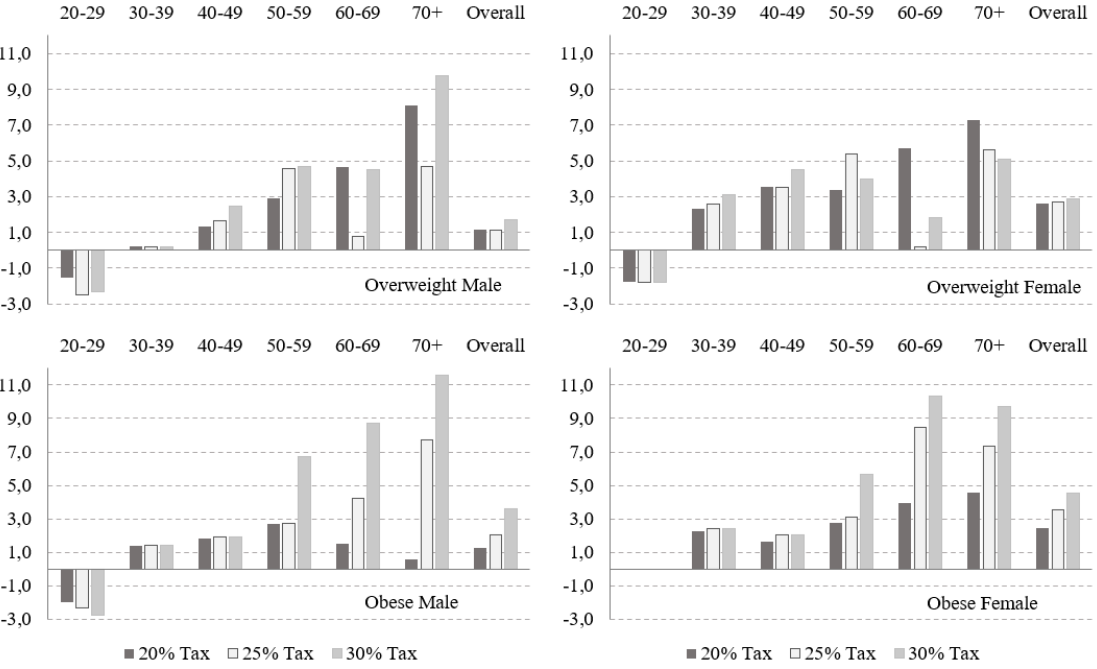
Figure 2. Percentage change in overweight and obesity prevalence (relative change in percent) by age group and sex as a result of a 20, 25, and 30% SSB tax.